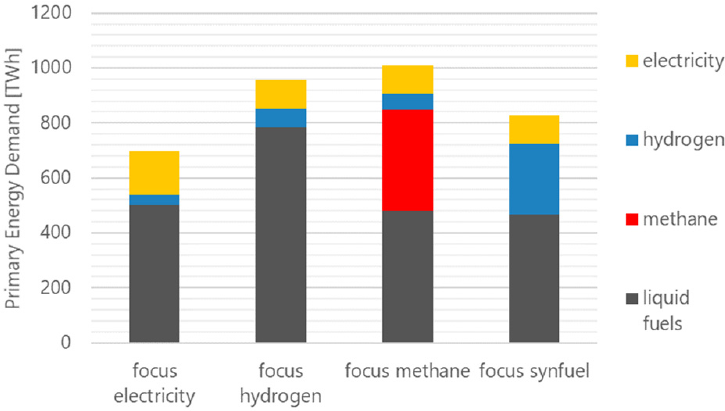
Figure 4. Electricity demand in 2050 distinguished by energy carrier type in the four scenarios.